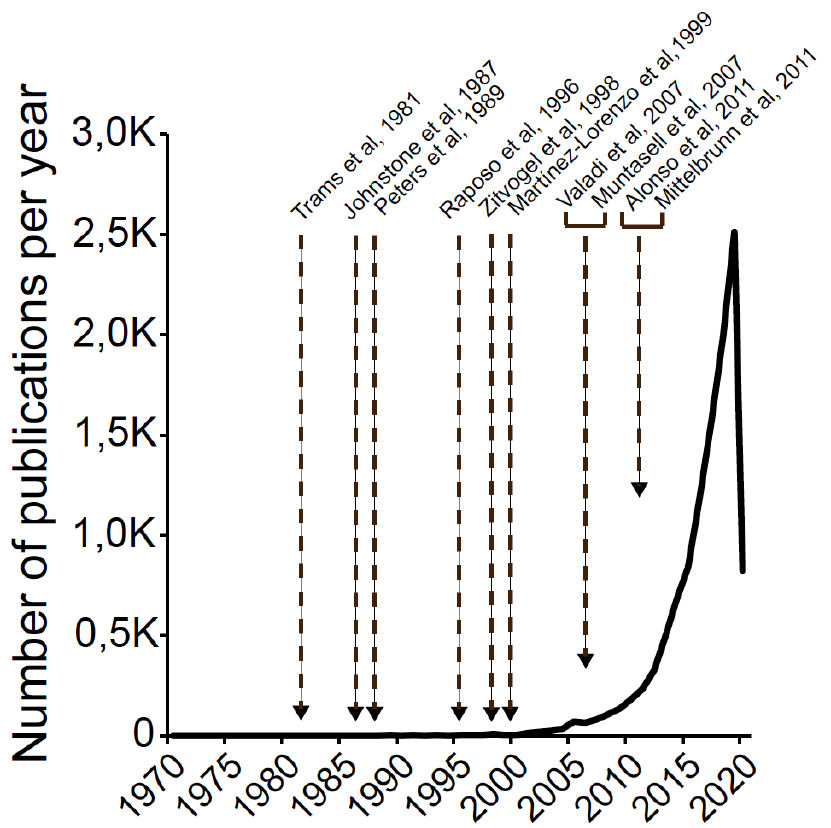
Figure 1. Exosome timeline and publications. A search was performed in PubMed on 2 April 2020 to find, for each year of publication, articles using the given term “exosomes” and the related term “small extracellular vesicles” as text word. Data are not normalized to the total number of biology and biomedicine research publications. Arrows on the graph indicate the year of publication of some milestone papers mentioned in the text.